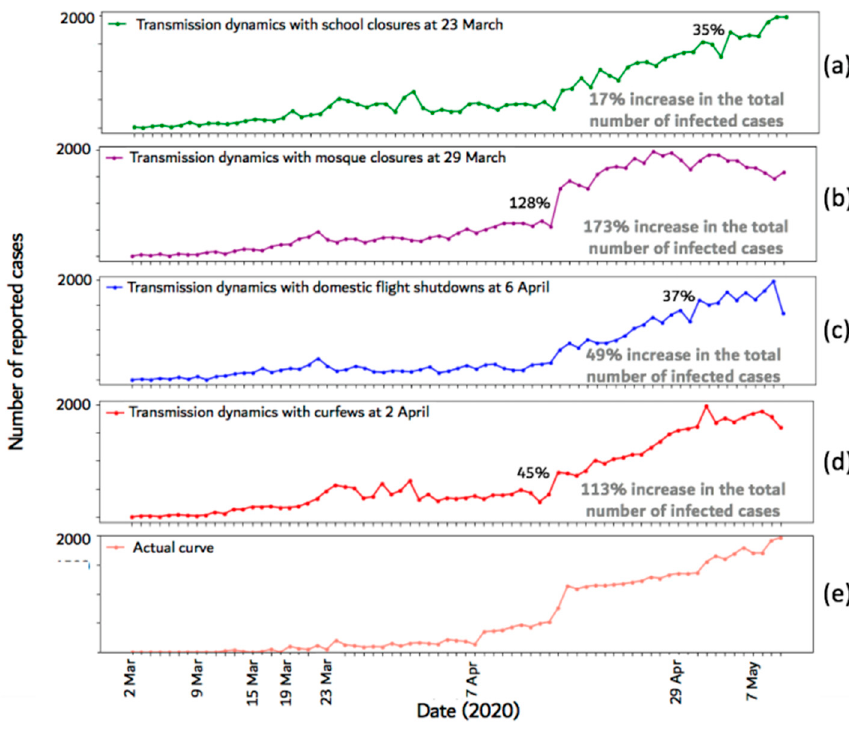
Figure 7. Epidemic curves after changing the effective date of each of the employed control measures. The highest percentage increase in the number of infected cases between any two time-steps and the increase in the total number of infected cases are shown on each plot. ( a )-( d ) show the impact of delaying school closures, mosque closures, flight shutdowns, and curfews, respectively. ( e ) shows the actual curve.